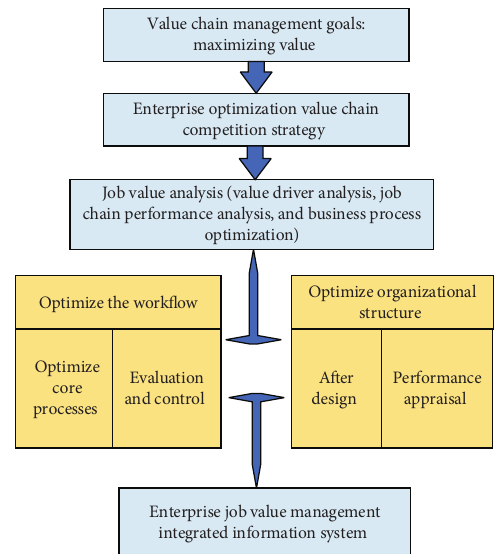
Figure 1: Job value analysis and value chain